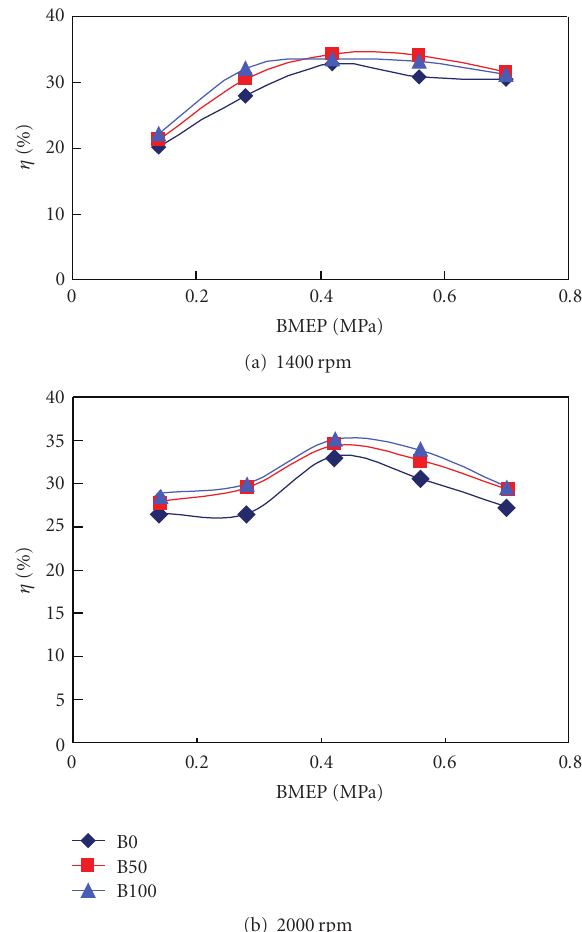
Figure 11: Engine brake thermal e ffi ciency when burning di ff erent